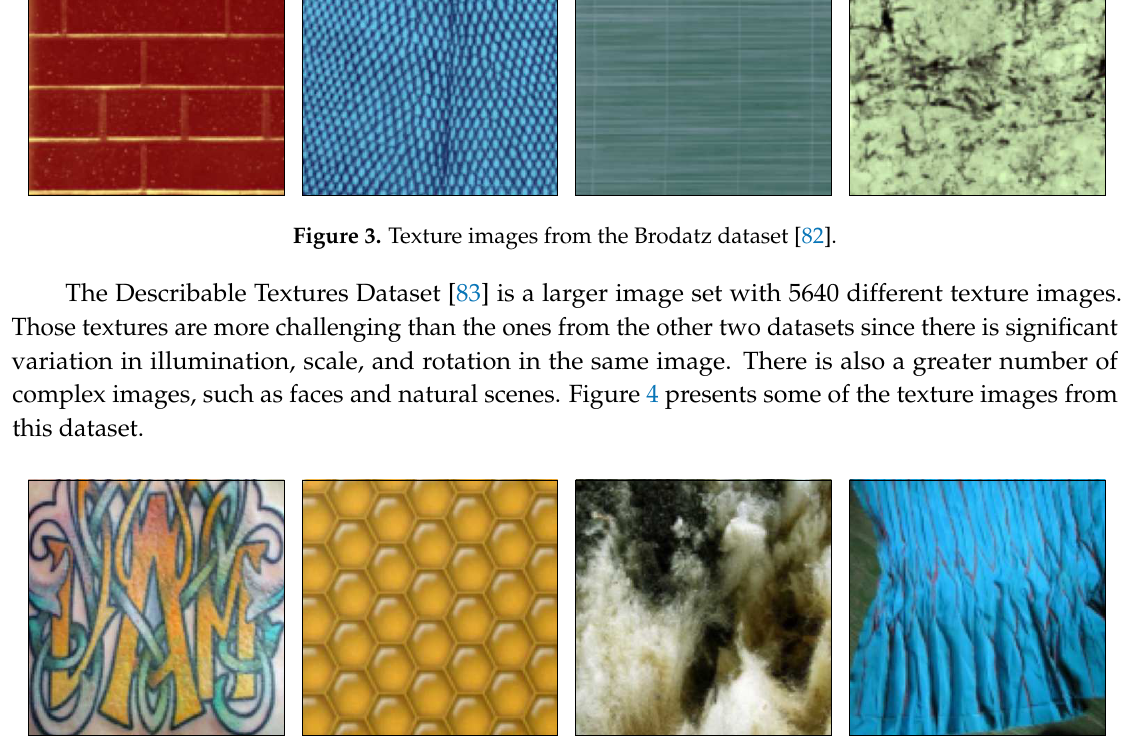
Figure 4. Texture images from the Describable Textures Dataset